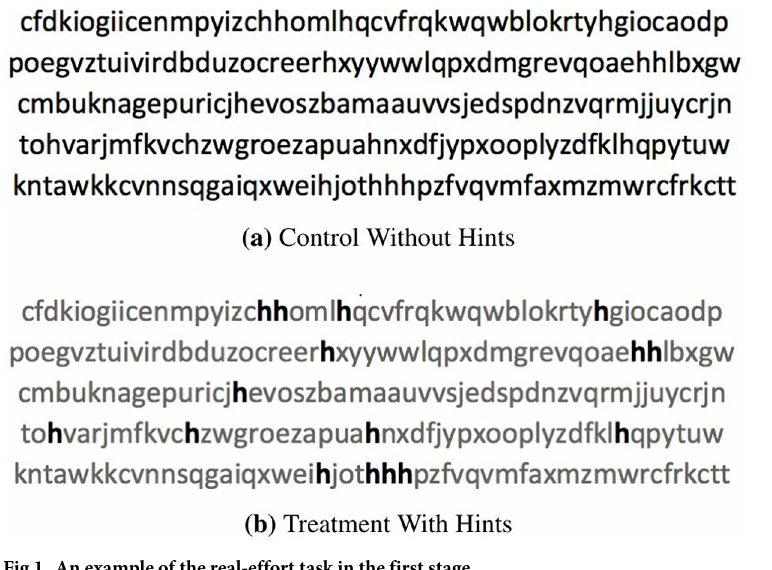
Fig 1. An example of the real-effort task in the first stage.